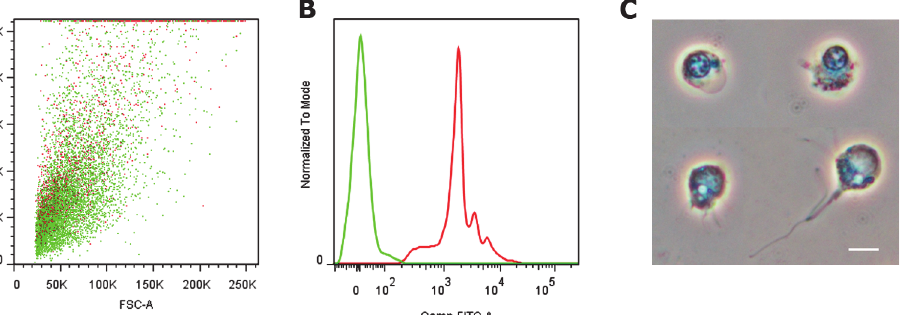
Fig 11. In vitro phagocytosis of fluorescent beads by dispersed renal hemocytes. (A) Dot plot of cell size vs . complexity-granularity of dispersed renal hemocytes exposed to fluorescent beads. Red dots indicate phagocytic hemocytes associated to fluorescent beads, while green dots indicate non phagocytic ones. (B) Histograms of the sample shown in A: the red and green lines show the distribution of phagocytic and non-phagocytic hemocytes, respectively. The red histogram indicates the existence of 3 – 4 hemocyte populations associated to different amounts of fluorescent beads. (C) Phase contrast micrographs of sorted hemocytes exposed to fluorescent beads: those in the upper row are not phagocytic while those in the lower row show internalized bead/s. Scale bar represents 10 μ m.